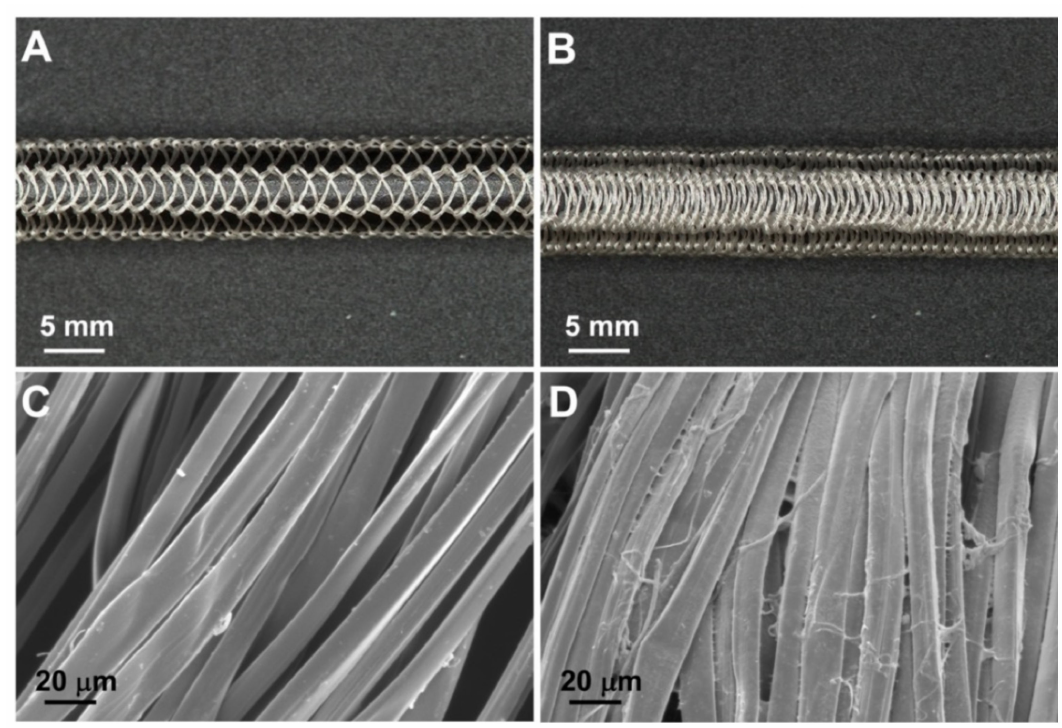
Figure 1. Design changes of the manufacturing process. Images ( A , B ) were obtained with a digital microscope (Omni 3 Ash, Naas, Ireland); images ( C , D ) were obtained with SEM (Zeiss EVO MA10). ( A ) Extended arrangement of the braid (TEX layer of the SILKGraft wall) on the electrospinning mandrel. Crossing points per unit length: 6/cm. ( B ) Compact arrangement of the braid on the electrospinning mandrel. Crossing points per unit length: 14/cm. ( C ) Detail of the yarn forming the TEX layer after treatment with the EMIMAc/H 2 O welding agent. After treatment with the hydroalcoholic solution (80 v% ethanol in water), the welding agent is completely removed and does not leave any residuals on the surface of the fibers, which remain separated from each other. ( D ) Detail of the yarn forming the TEX layer after treatment with the SF/EMIMAc welding agent. After treatment with the hydroalcoholic solution (80 v% ethanol in water), the welding agent leave a thin SF film on the surface of the yarns that glues together the constituent